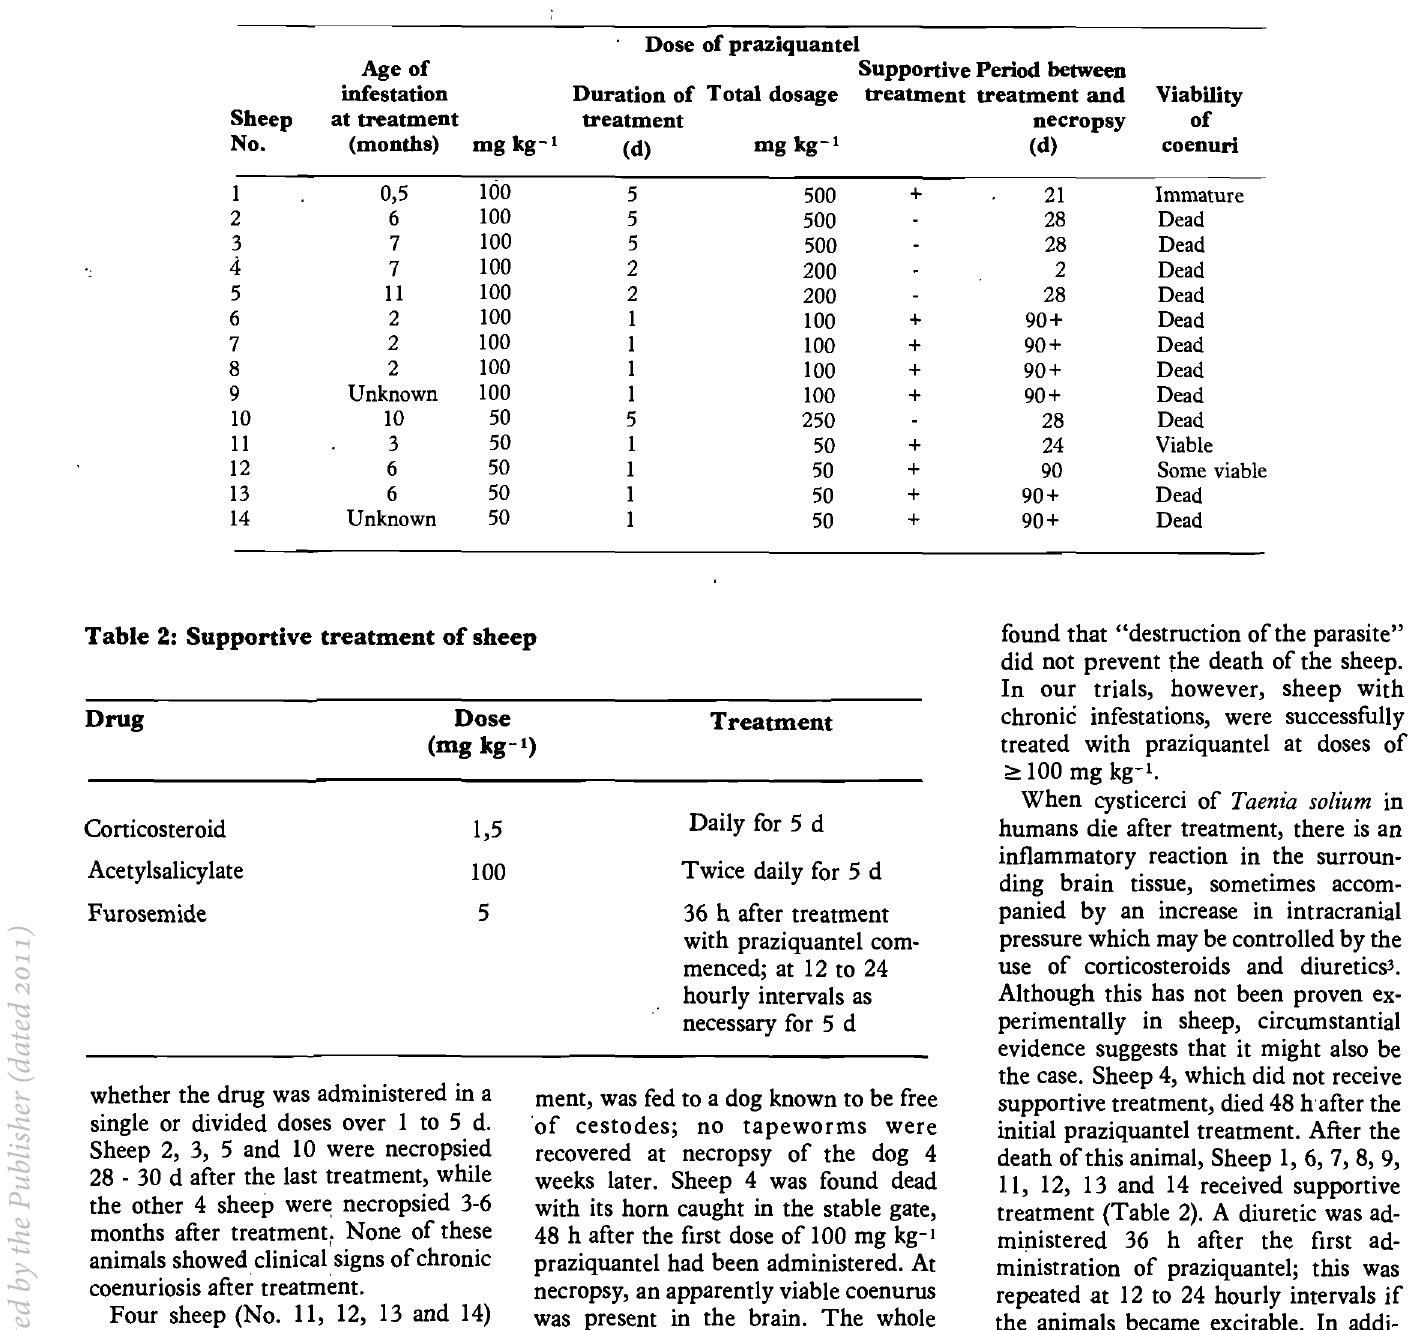
Table 1: Treatment of sheep with praziquantel and the ,viability of the coenuri of Taenia mUlticeps Dose of praziquantel Age of Supportive Period between infestation Duration of T otaI dosage treatment treatment and Viability Sheep at treatment treatment No.